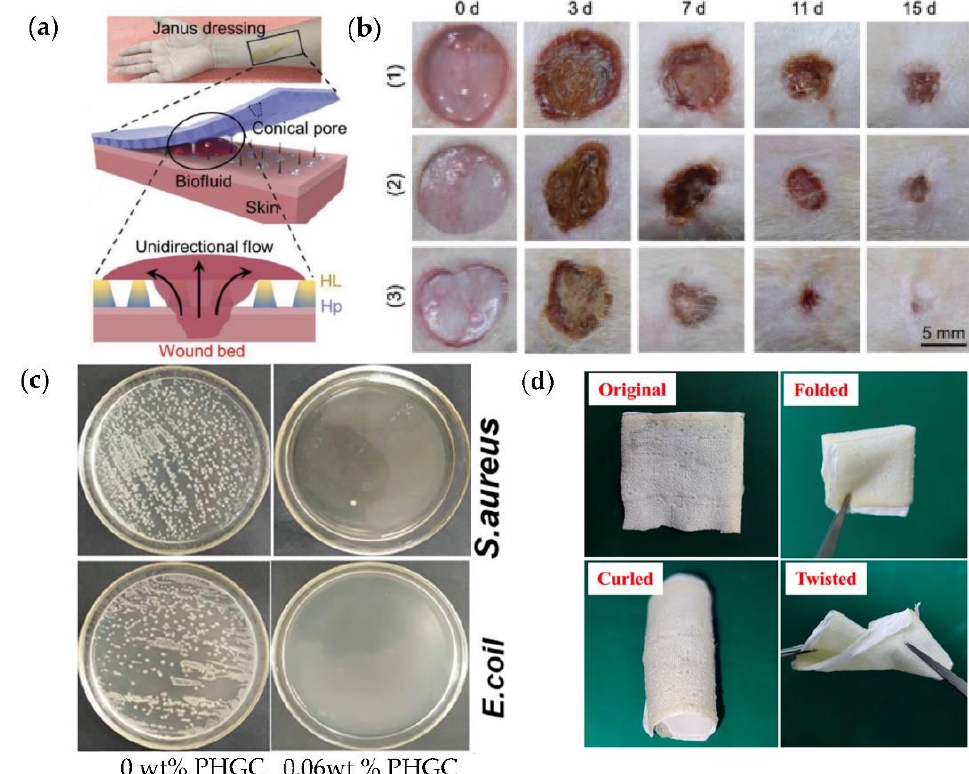
Figure 10. ( a ) Schematic design of DWT membrane for wound dressing. ( b ) The images of wounds in different treatment groups: (1) control group; (2) the Janus dressing without antibacterial drug group; and (3) the AM-loaded Janus dressing group [75] (Copyright 2021, Wiley-VCH). ( c ) Photographs of the antibacterial performance of dressings with no PHGC and 0.6 wt% PHGC for S. aureus and E. coli [76] (Copyright 2021, Elsevier). ( d ) Images demonstrating the elasticity and flexibility of the wound dressing [77] (Copyright 2021, American Chemical Society).